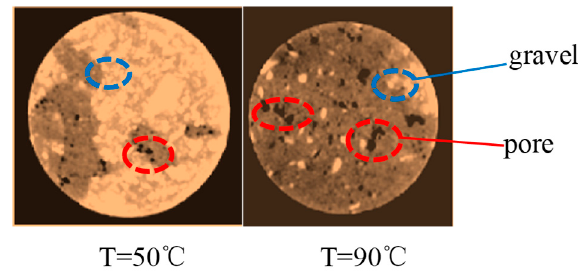
Figure 10. CT scan image of bonding surface [75].